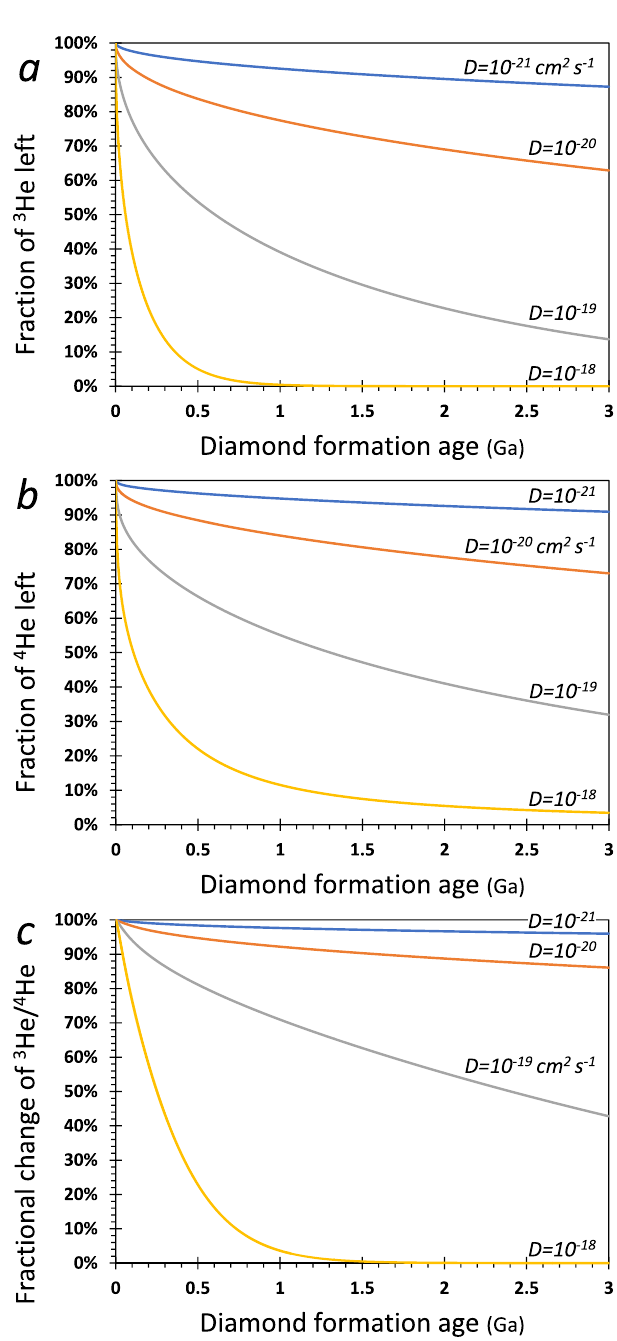
Fig. 3 Effects of diffusion on He isotopes. The fraction of initial He content ( a , b ) and the fractional change in 3 He/ 4 He ( c ) in a diamond as a function of its formation age for different He diffusivities. Model results take into account radioactive production of 4 He and removal of 3 He and 4 He by diffusion (model details are in “ Methods —‘ Diffusion model of He in diamonds ’” ). a The remaining fraction (in %) of 3 He compared to its